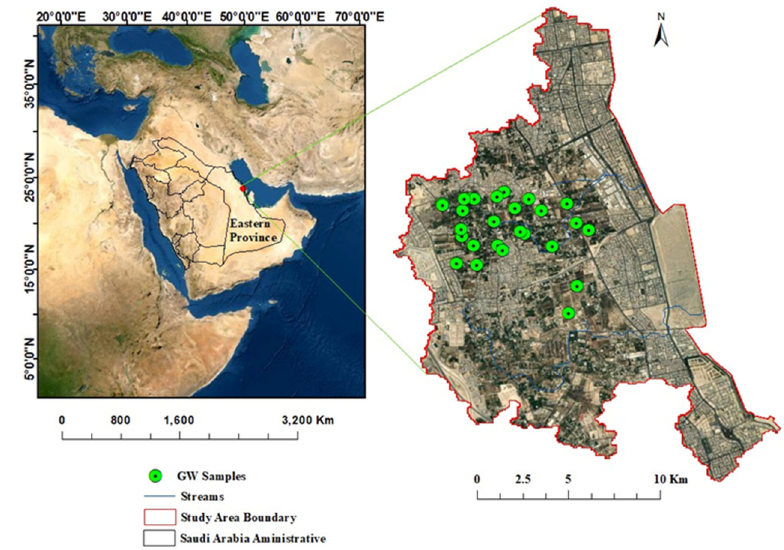
Figure 1. Map showing the study area and GW sample locations.